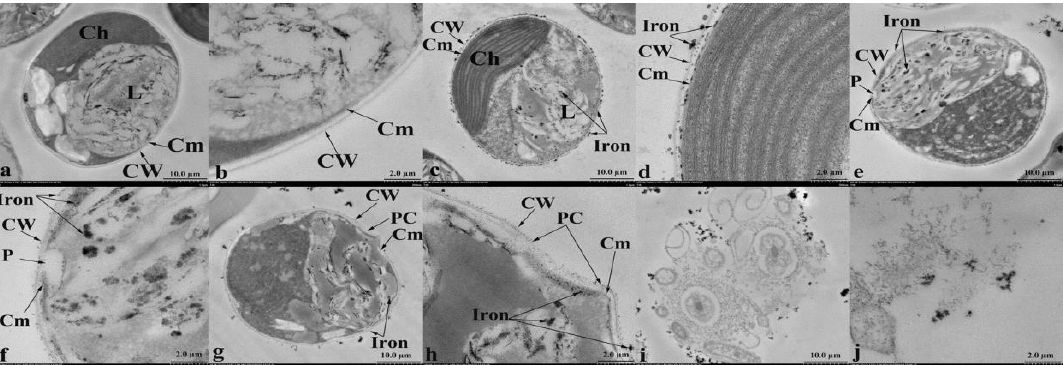
Figure 5. Transmission electron microscope (TEM) image of microalgae. ( a ) fresh microalgae cell without any treatment, ( b ) parts of fresh microalgae cell without any treatment, ( c ) microalgae cell with FeSO 4 addition, ( d ) parts of microalgae cell with FeSO 4 addition, ( e ) microalgae cell with 15 min electro-Fenton treatment, ( f ) microalgae cell with 15 min electro-Fenton treatment, ( g ) microalgae cell with 37 min electro-Fenton treatment, ( h ) parts of microalgae cell with 30 min electro-Fenton treatment, ( i ) microalgae cell with 1 h electro-Fenton treatment, ( j ) parts of microalgae cell with 1 h electro-Fenton